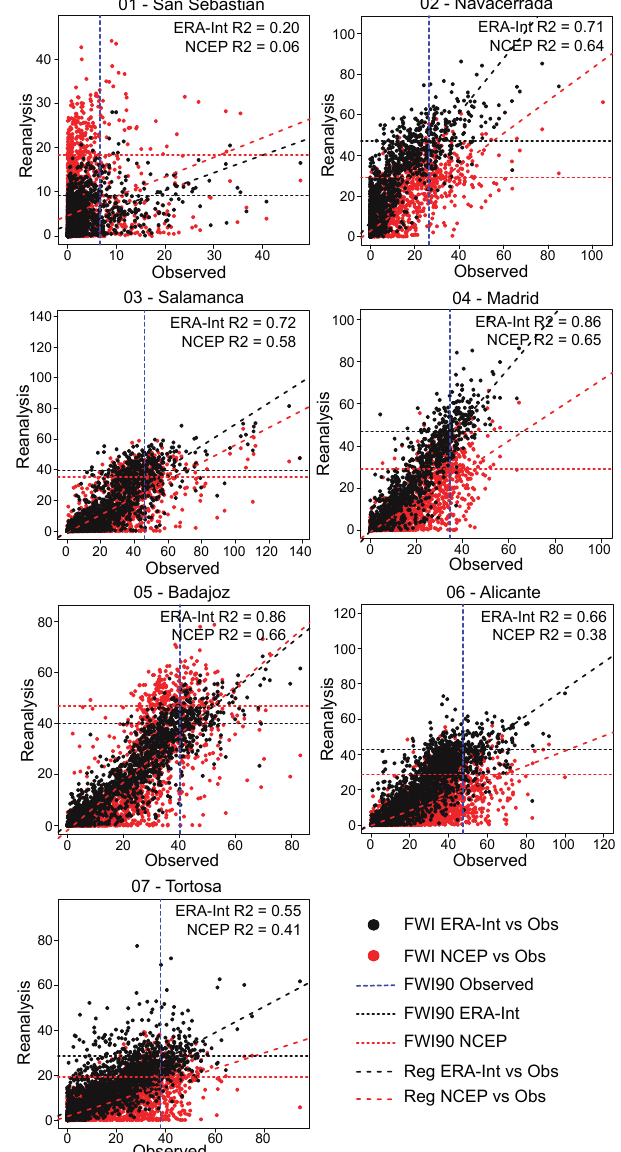
Fig. 4. Scatter plots of observed vs ERA-Interim and NCEP reanal- ysis FWI values for the period encompassed since the beginning of the observations (Table 2) to June 2011. The dashed lines indicate the corresponding FWI90 values and the regression